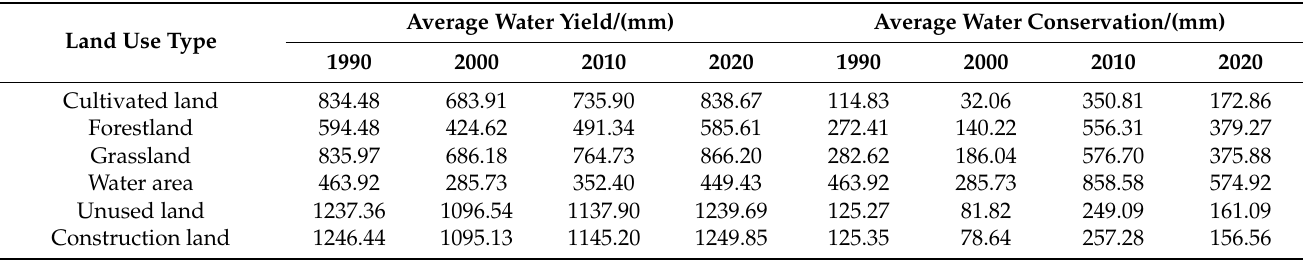
Table 5. Average water yield and water conservation of different land use types during